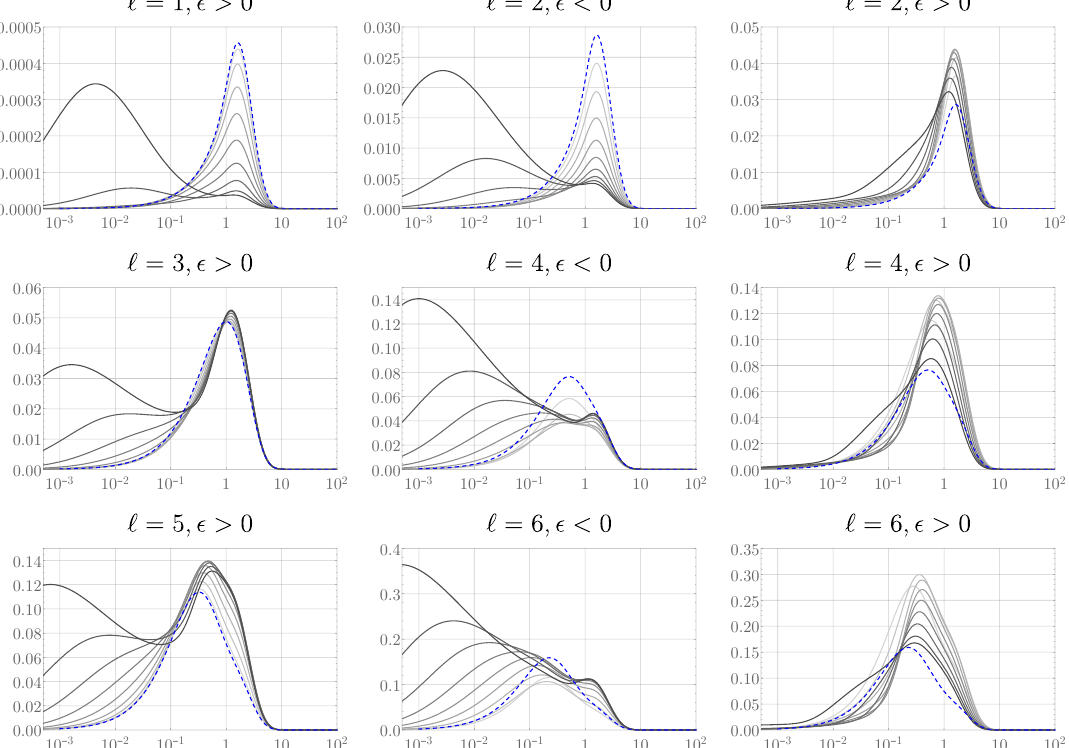
Figure 4. The differenced heat kernel ∆ K L ( t ) as a function of t for the Dirac fermion on the deformed spheres given by (4.9). Each plot shows the rescaled heat kernel − σ ∆ K L /(cid:15) 2 (except for ‘ = 1 , which shows − σ ∆ K L /(cid:15) 4 ), with the dashed blue line corresponding to the perturbative result (3.22) and the gray lines to the numerical results for the deformations shown in figure 2 (hence light to dark gray corresponds to increasing | (cid:15) | , with (cid:15) ∈ [0 . 9 (cid:15) min , 0 . 9 (cid:15) max ]